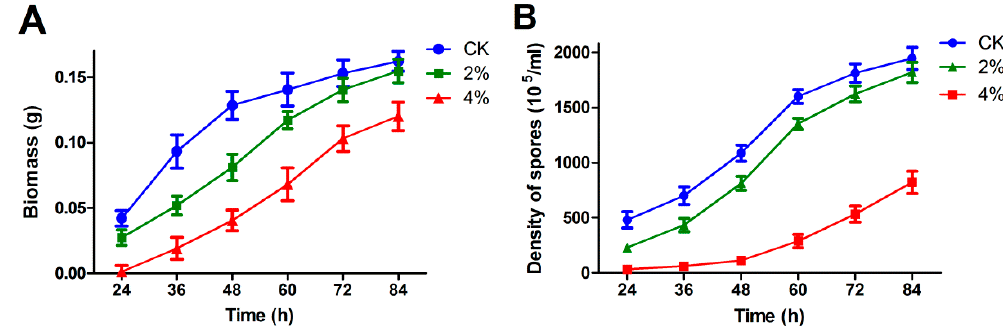
Figure 2. The mycelia biomass and conidia number of Aspergillus oryzae in response to ethanol stress. ( A ) The dried biomass of A. oryzae mycelia under ethanol conditions from 24 to 84 h post-treatment. ( B ) The number of A. oryzae conidia under different concentrations of ethanol treatment.